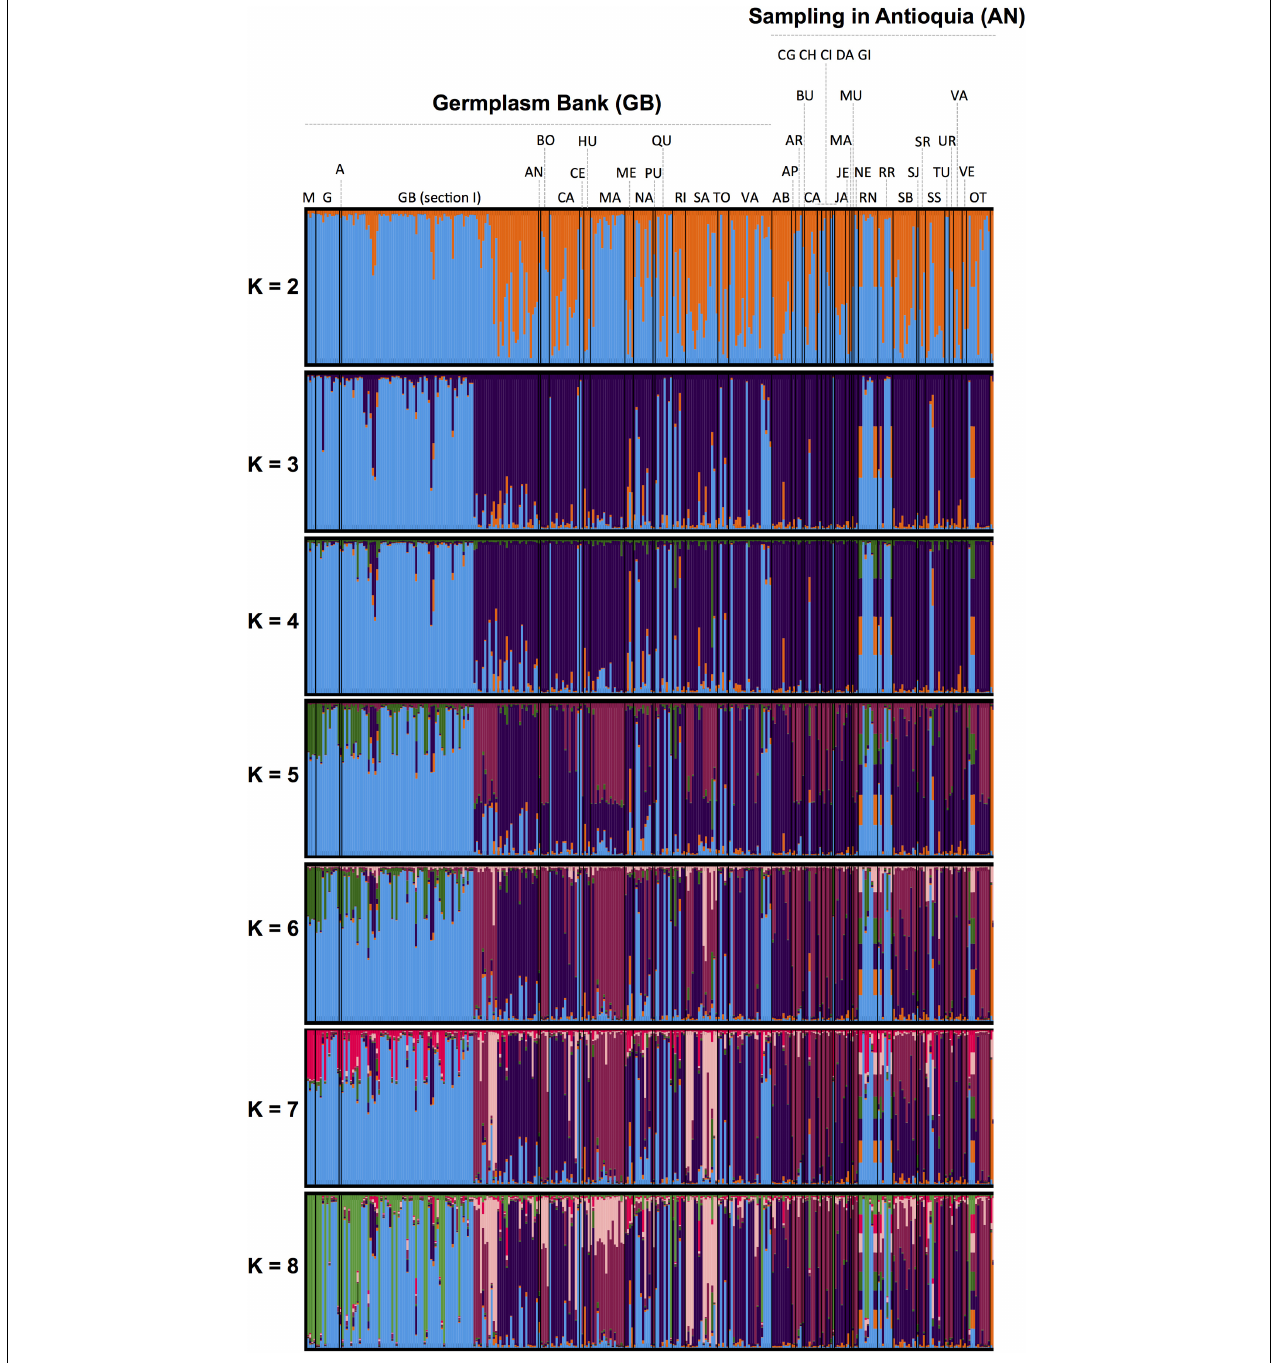
FIGURE 3 | Unsupervised Bayesian clustering among avocado “criollo” “plus trees” collected from the northwest Andes of Colombia (province of Antioquia, AN), and the avocado Germplasm Bank (GB) from Colombia as characterized by Cañas-Gutiérrez et al. (2019a) with the same panel of SSR markers. M, G, and A, stand for Mexican, Guatemalan, and West Indies race controls, respectively. GB Section 1 comprises commercial genotypes. The remaining two-letter abbreviation codes indicate avocado “criollo” trees, respectively sampled from different provinces (under GB) and villages (under AN) across Colombia and the province of Antioquia (northwest Andes of Colombia), as follows: Antioquia (AN), Bolivar (BO), Cauca (CA), Cesar (CE), Huila (HU), Magdalena (MA), Meta (ME), Nariño (NA), Putumayo (PU), Quindío (QU), Risaralda (RI), Santander (SA), Tolima (TO), and Valle del Cauca (VA) for provinces across Colombia, and Abejorral (AB), Apartadó (AP), Arboletes (AR), Buriticá (BU), Caramanta, Carepa or Caracolí (CA), Cañas Gordas (CG), Chigorodó (CH), Cisneros (CI), Dabeiba (DA), Giraldo (GI), Jardín (JA), Jericó (JE), Maceo (MA), Mutatá (MU), Necoclí (NE), Rionegro (RN), Urrao (RR), Santa Bárbara (SB), San Juan (SJ), San Roque (SR), Sonsón (SS), Turbo (TU), Uramita (UR), Valparaiso (VA), Venecia (VE), and other (OT) for municipalities within the province of Antioquia. For further details on the sampling within Antioquia, such as sub-region and elevation, please refer to Supplementary Table 1 and the first table in Cañas-Gutiérrez et al. (2019b).